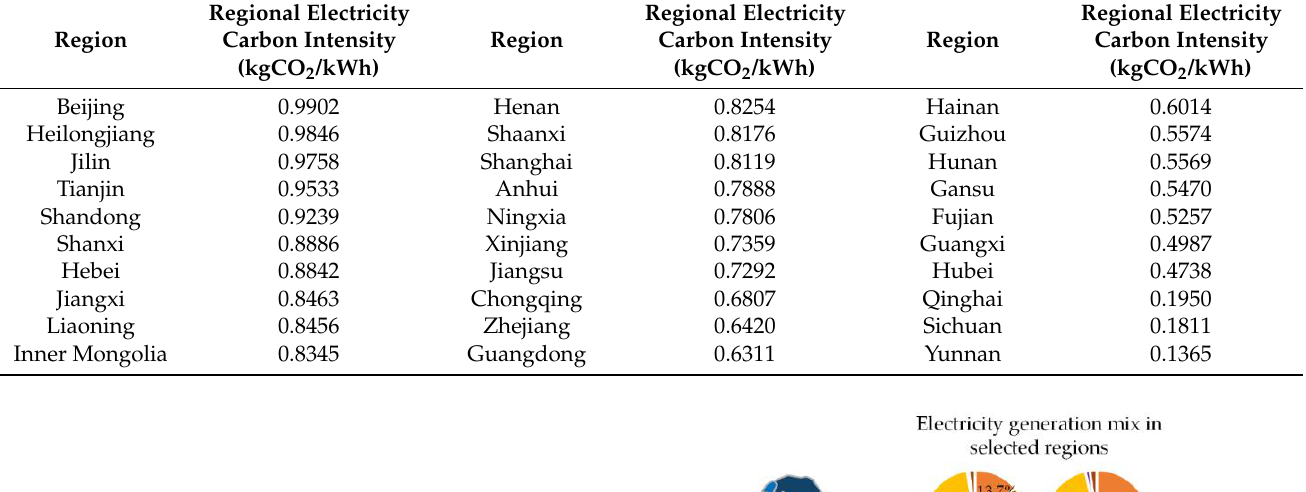
Table 5. Regional electricity carbon intensity of China in 2019.